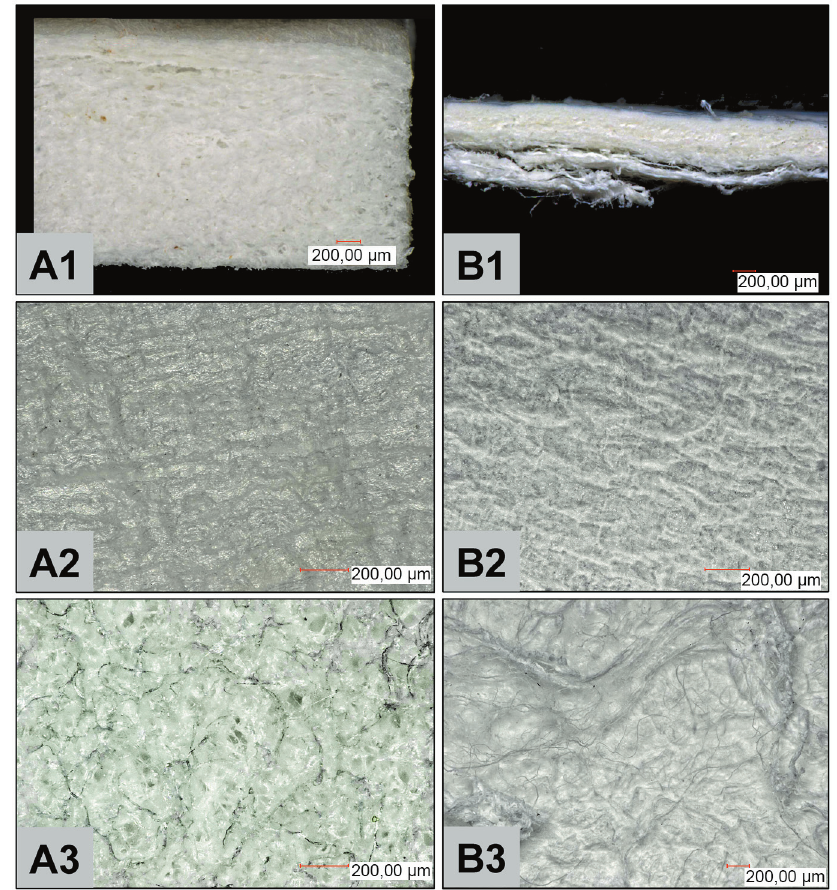
Figure 1- Macroscopic and microscopic structural characteristics of both collagen-based materials (MG and BG). A1 and B1 show cross-sections of the analyzed materials (A=MG) and (B=BG), A2 and B2 show the ultrastructure of the compact surface of MG and BG respectively, while A3 and B3 highlight the corresponding spongy side of the used materials. Magnifications: A1 and B1 x100; A2-3 and B2-3 x200 (scale bar=200